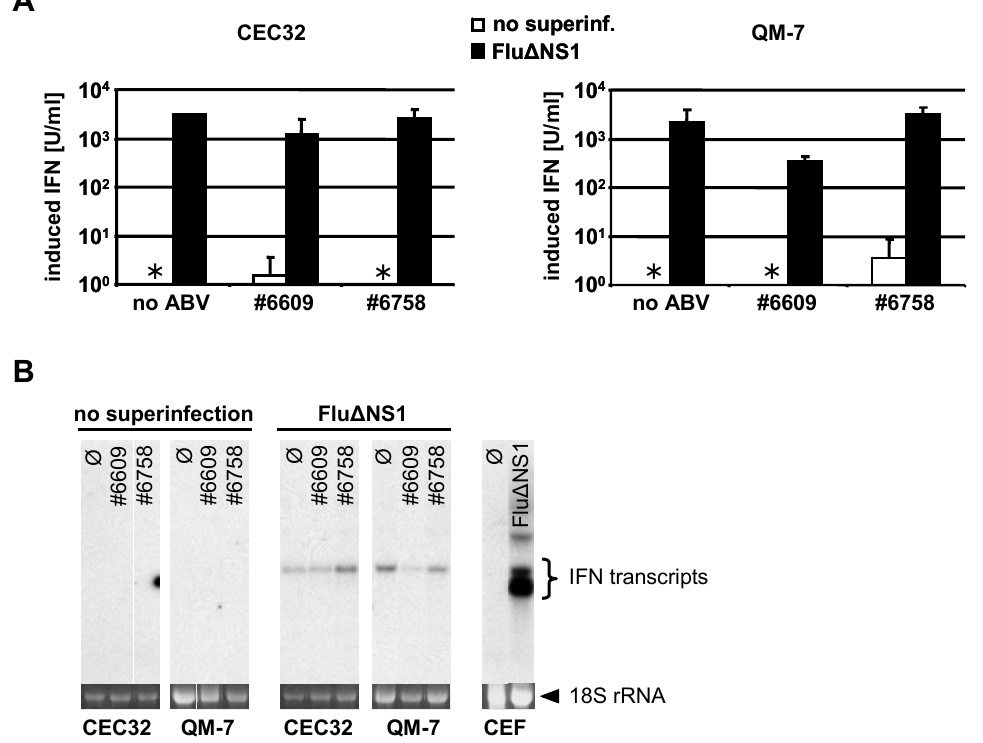
Figure 4. Synthesis of type I IFN by ABV-infected quail cells. (A) Antiviral activity in culture supernatants. IFN induction in uninfected cells and in cells persistently infected with ABV (strains #6758 and #6609, respectively) were compared (open bars). If the uninfected or ABV-infected cell cultures were super-infected with influenza mutant virus SC35M ∆ NS1 for 16 hours (filled bars), IFN was abundantly produced irrespective of whether or not the cells were persistently infected with ABV. The combined data from four independent experiments are shown. Asterisks indicate samples with IFN titers below the detection limit. (B) IFN-  transcript levels in the same cultures. After harvesting the supernatants, RNA was extracted from the various cultures and IFN-  transcript levels were determined by Northern blot analysis. RNA from uninfected (  ) or SC35M ∆ NS1- infected chicken embryo cells (CEFs) served as positive